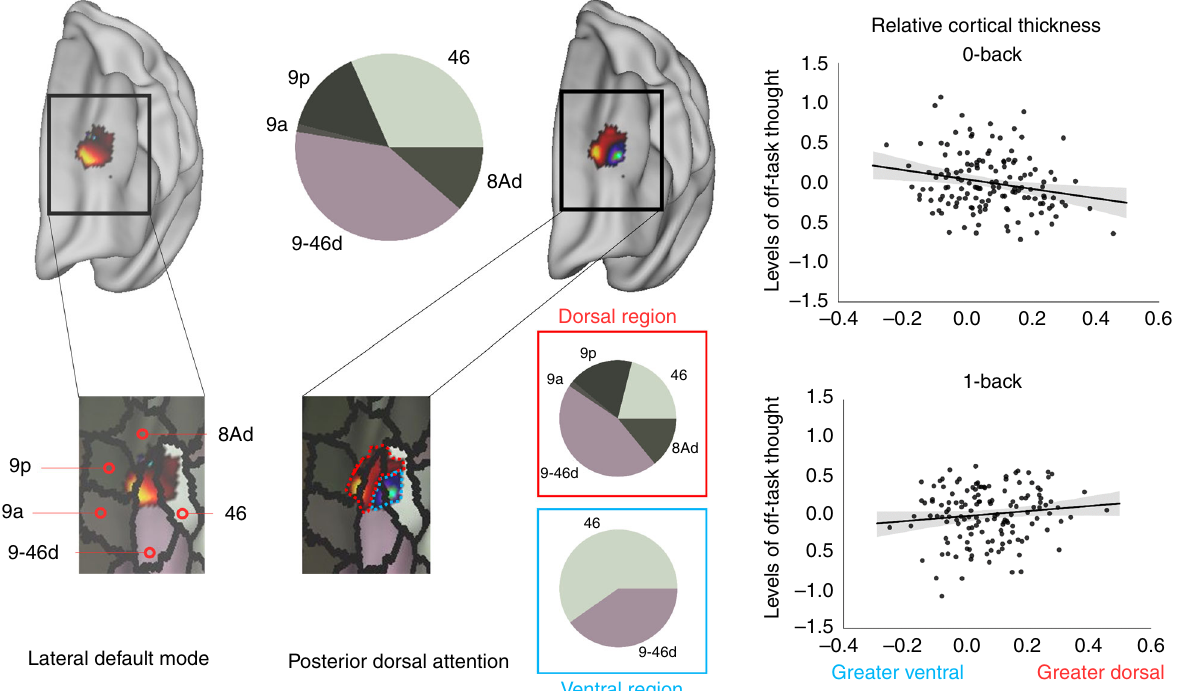
Fig. 4 The structure of left DLPFC supports individual differences in prioritising off-task thought. Characterisation of the region of left DLPFC using a multimodal parcellation scheme 68 demonstrates it encompasses region BA 9/46d, 9, 46, and 8Ad. The amount of overlap with each parcel of the Glasser atlas 68 is shown by the pie charts, both for the region as a whole and for each sub-region (dorsal: red box, ventral: blue box). Relatively greater cortical thickness in a region negatively related to Yeo network 5 33 (posterior dorsal attention network) was linked to more off-task thought when task demands are lower. This relationship is shown in the